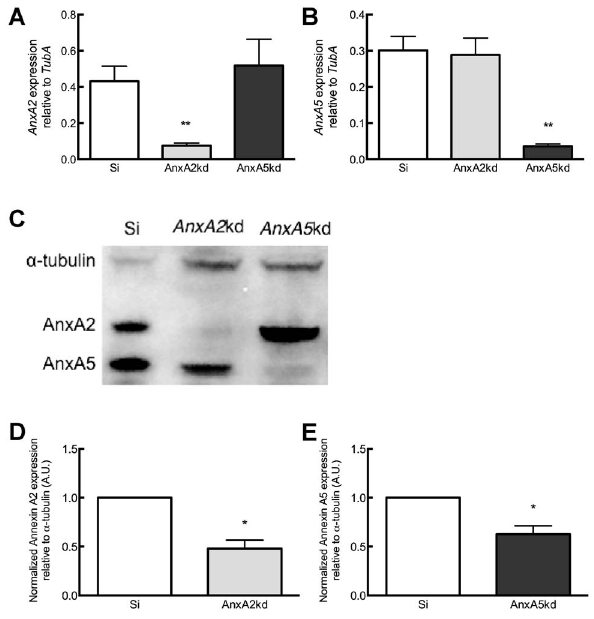
Figure 1. Characterization of Annexin levels in knockdown cells. (A) qPCR analysis of AnxA2 expression in pSiren control cells (Si) and cells stably transfected with either AnxA2 or AnxA5 shRNA ( AnxA2 kd and AnxA5 kd cells respectively). (B) qPCR analysis of AnxA5 expression in cells stably transfected with either AnxA2 or AnxA5 shRNA. Each bar represents mean transcript normalized to a -tubulin 6 SEM, n=3–5. **represents statistically significant difference from Si, p , 0.01. (C) Representative western immunoblot for AnxA2, AnxA5 and a - tubulin protein expression in Si, AnxA2 kd and AnxA5 kd cells. (D) Quantitation of AnxA2 protein levels in Si and AnxA 2kd cells. (E) Quantitation of AnxA5 protein levels in Si and AnxA5 kd cells. Data are first normalized to a -tubulin and then to Si control. Each bar represents mean 6 SEM, n=6. *represents statistically significant difference from Si control, p ,